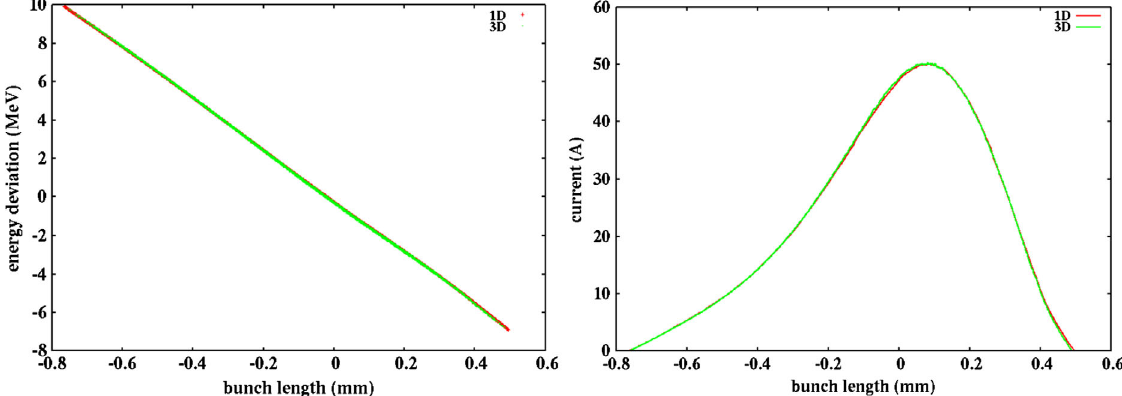
FIG. 7. Longitudinal phase space distribution (left) and current profile (right) after BC1 of the LCLS-II linac from the 1D model (red) and from the 3D model (green) using an optimal solution settings.